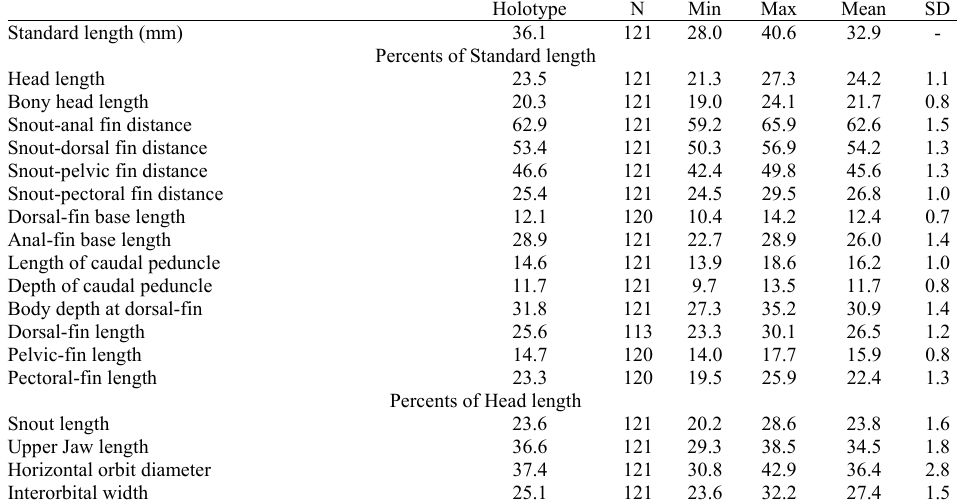
Table 1. Morphometric data of Macropsobrycon uruguayanae . SD = standard